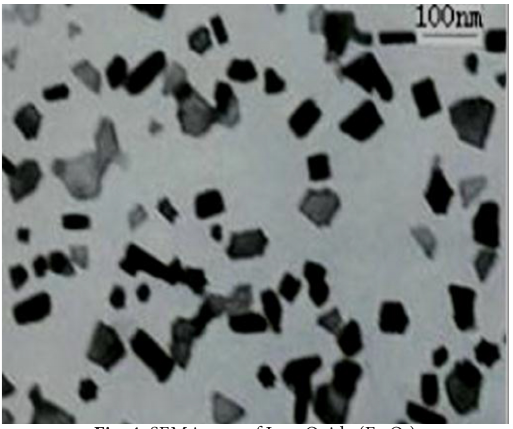
Fig. 3. TEM image of nano Iron Oxide (Fe